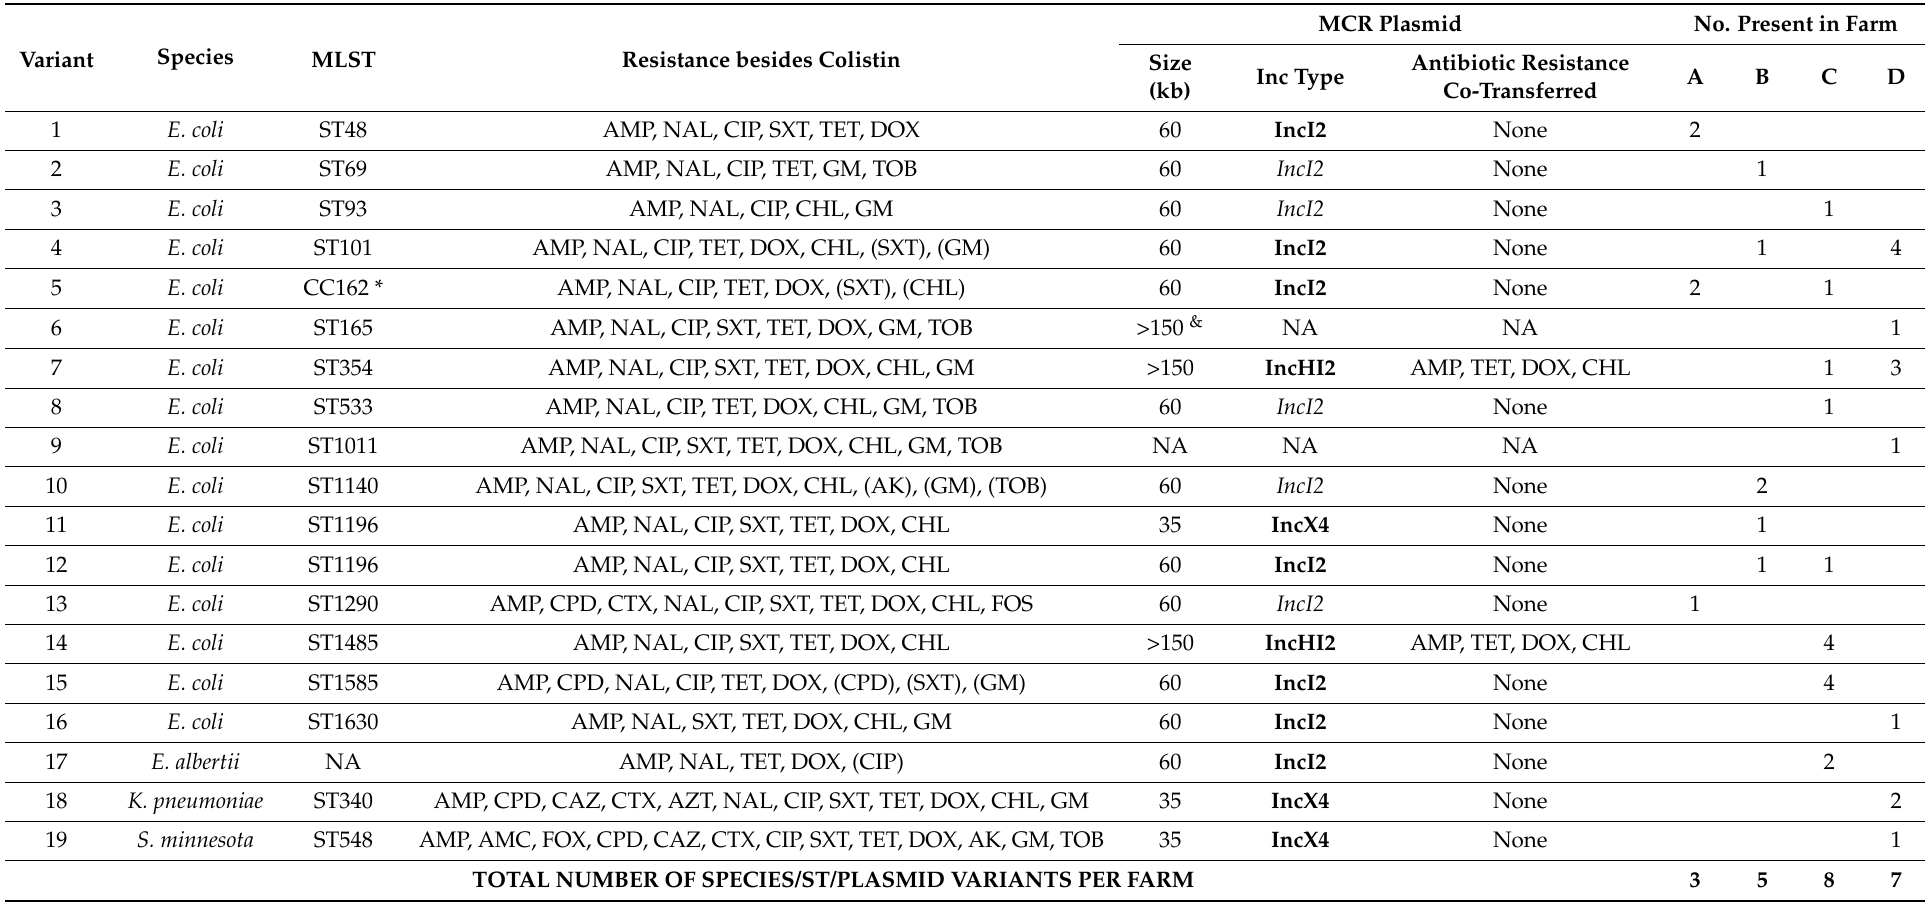
Table 1. Variants of wild type strains